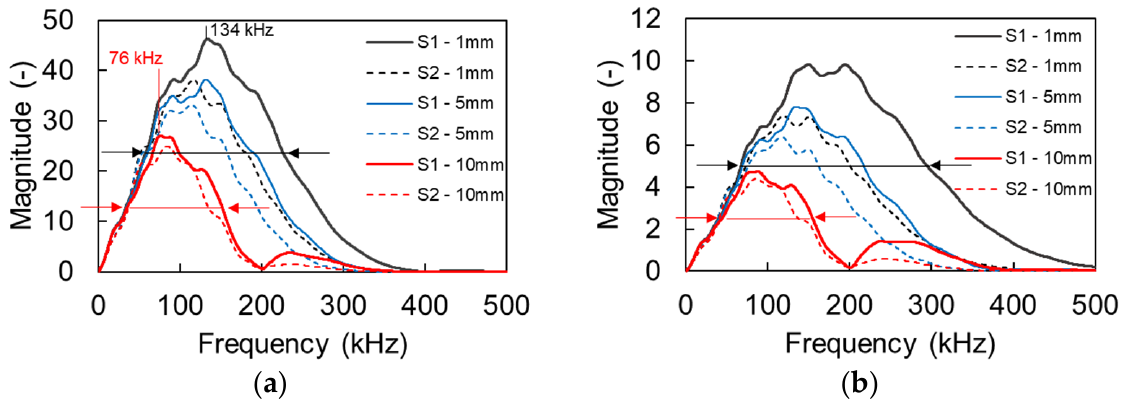
Figure 8. FFT magnitude of different aperture sensors for excitation frequency of ( a ) 200 and ( b ) 500 kHz.